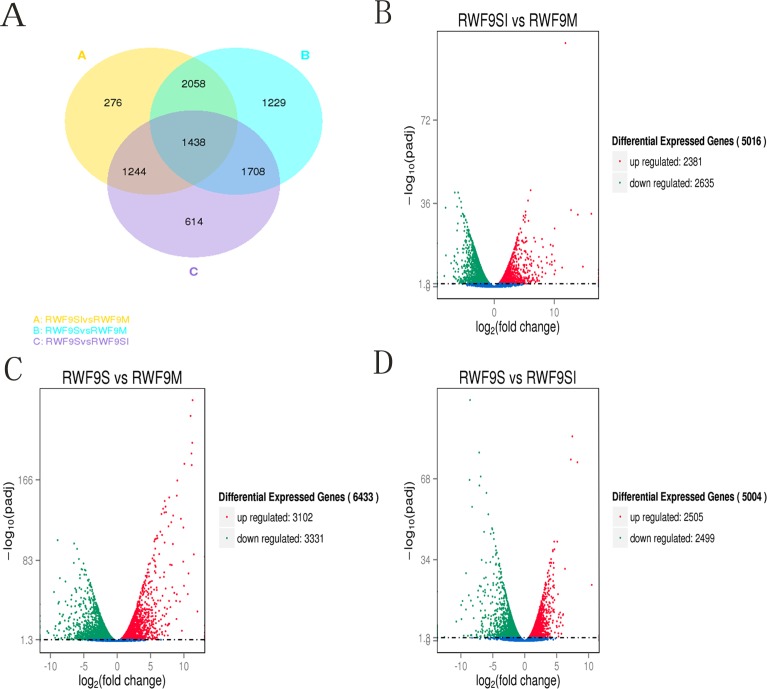
Differentially expressed genes analysis.(A) Venn diagram of differentially expressed genes in the sclerotia formation of R. solani AG1 IA. (B–D) Volcano plot showing genes differently expressed between different libraries. The Q-value for all plots was <0.005 and the absolute value of the log2Ratio > 1 were used as the threshold to judge the significance of the difference in gene expression. Red points: genes up-regulate; green points: genes down-regulated; blue points: not DEGs.